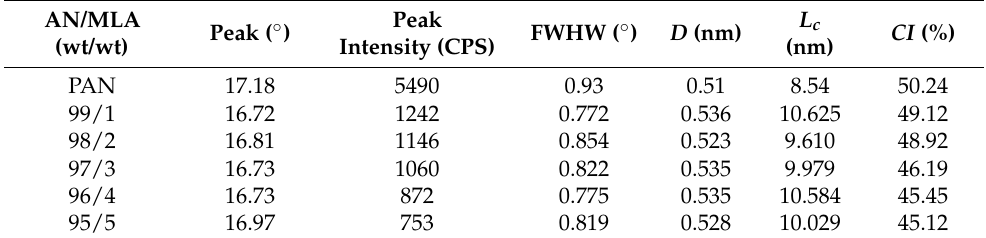
Figure 9. XRD patterns of P (AN-co-MLA) copolymers with different mass ratios of AN/MLA (wt/wt) and PAN homopolymer: ( a ) original and ( b ) stabilized 200 °C for 30 min. Table 3. XRD analysis results of P (AN- co -MLA) copolymers with different compositions according to Figure